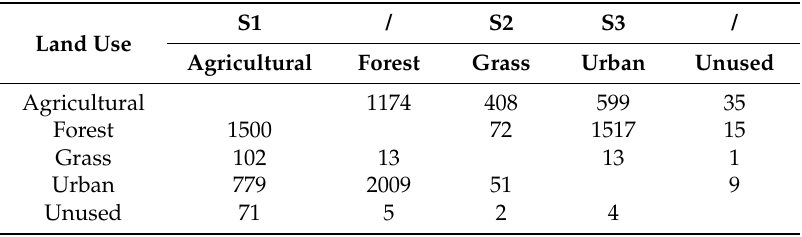
Table 4. Different land use transfer matrix from 1995 to 2005; Unit: km 2 .